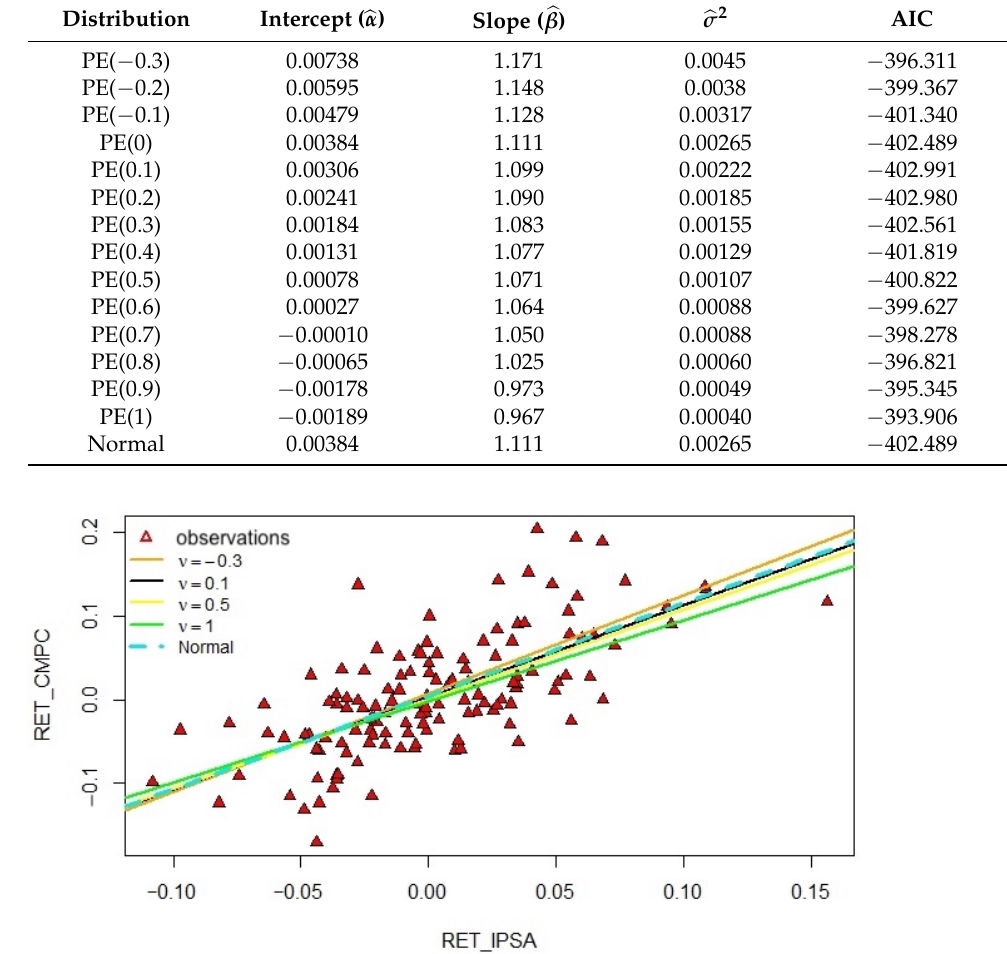
Figure 8. Scatter plot of monthly returns for the IPSA and CMPC with fitted CAPM line under the PE